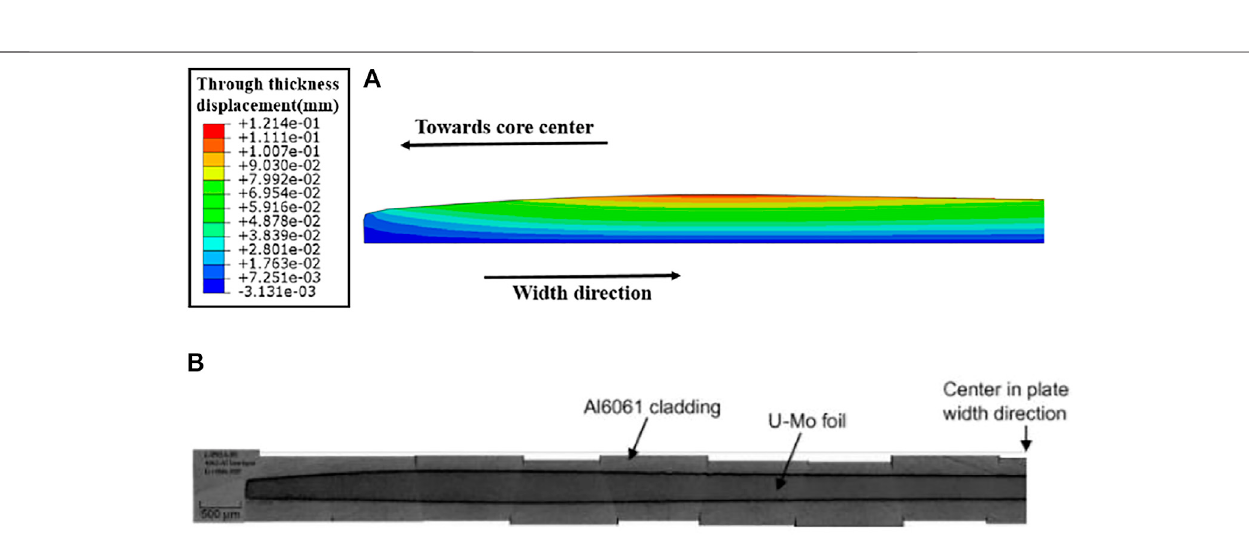
Frontiers in Energy Research |